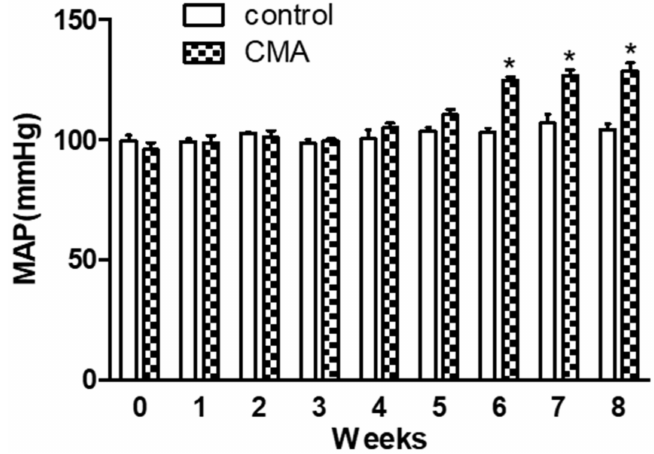
Figure 1. Blood pressure measurement (tail-cuff). Each bar represents values expressed as mean ± SEM. The change in mean arterial pressure (MAP) was considered significant (*) when p < 0.05 between two groups. The data were analyzed using two-way ANOVA followed by Bonferroni posttests.